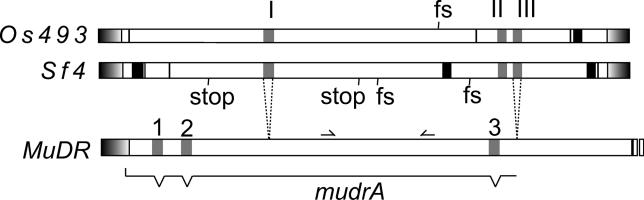
Schematic of the MULE Elements from Rice (Os493) and Setaria faberi (Sf4)Black blocks represent regions deleted in one or the other sequence. Grey blocks represent putative introns, which are numbered in the Setaria and rice elements with Roman numerals I–III. The second intron is collinear with the third intron in mudrA from maize. The mudrA introns are numbered 1–3. Shaded blocks on the ends of the elements indicate the terminal inverted repeats. For comparison, the 5' end of MuDR from maize (which includes the mudrA gene) is also included. Note that only the third intron of the mudrA gene and the third intron in the rice and Setaria is present in all three elements. The position of the RF2 and RR2 PCR primers are as indicated on the MuDR element. Stops and frameshifts in the Setaria and rice element (assuming introns are spliced) are at the positions indicated. Dotted lines connecting MuDR to Sf4 indicate regions of similarity.